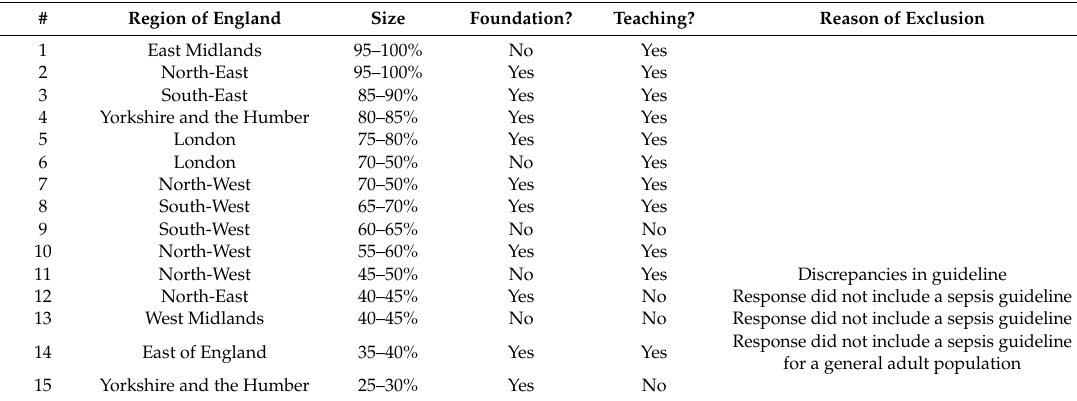
Table 1. Characteristics of the 15 NHS England Trusts whose local sepsis guidelines were requested, ordered by descending size as measured by the number of general and acute beds as a centile range